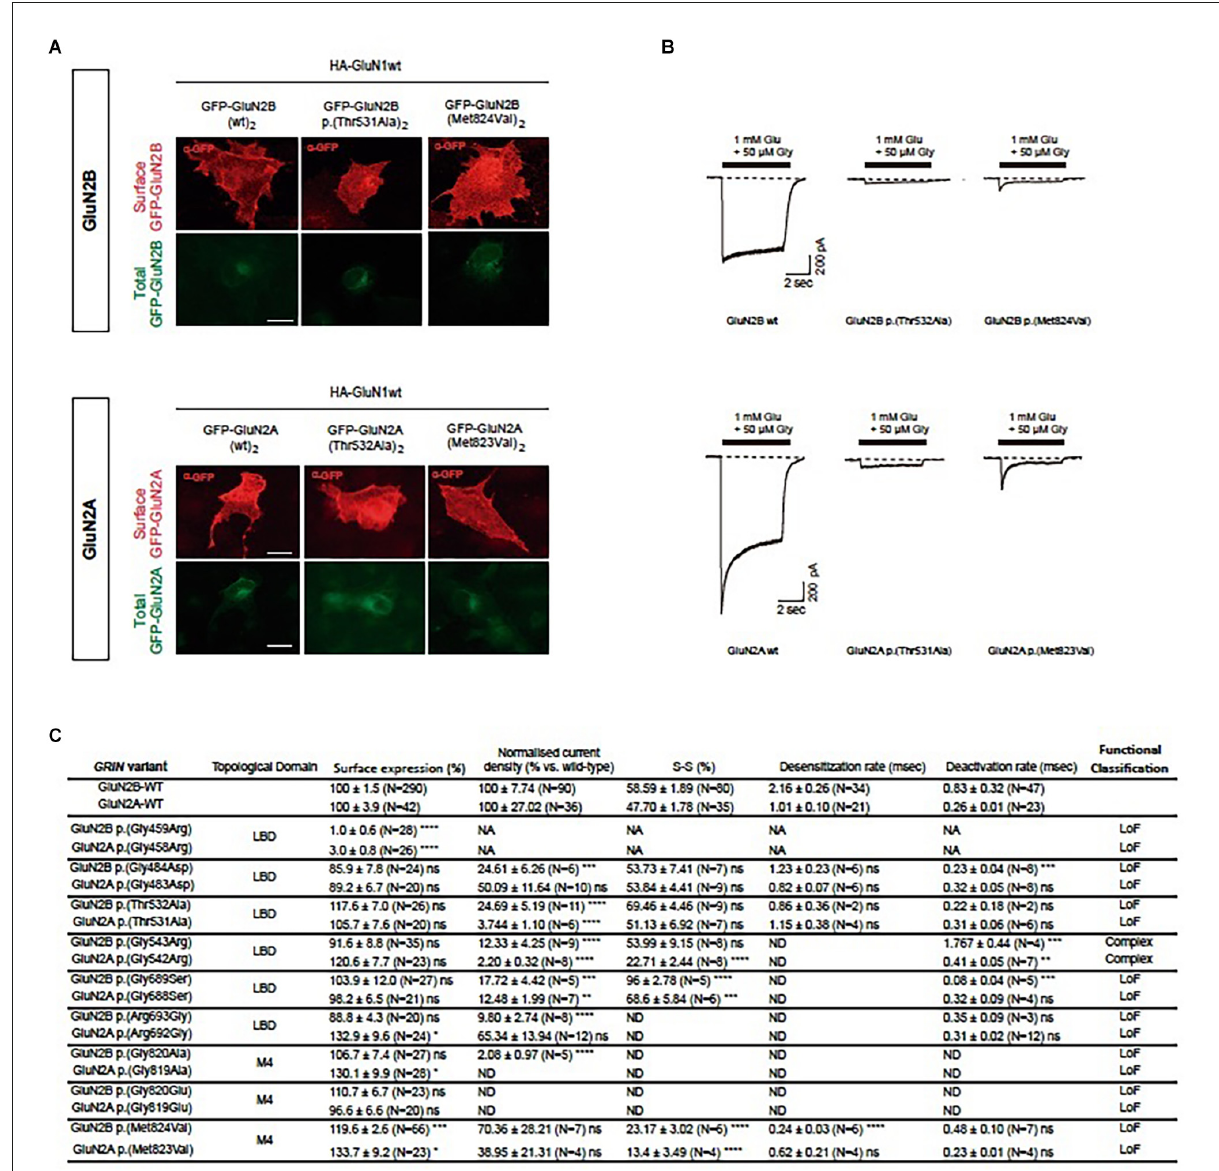
FIGURE2 Comparative analysis of functional alterations in GluN2A-GluN2B predicted equivalent pairs. (A) Representative images of immunofluorescence detection of surface trafficking from artificial GluN2A variants-containing NMDARs (upper panels), designed upon respective patients-associated GluN2B variants (lower panels). Transfected COS-7 cells heterologously expressing GFP-GluN2A/B subunits (green channel, intracellular expression) were immunostained and surface expression of mutant GluN2A/B labeled (red channel). (B) Representative electrophysiological traces of NMDAR-mediated currents in HEK-293T cells transfected with GluN1 and GluN2A/2B pairs (upper panels: (GluN1wt) 2 -(GluN2Amut) 2 mediated currents; lower panels: (GluN1wt) 2 -(GluN2Bmut) 2 ). (C) Summary of functional annotations of GluN2A/2B pairs. Data representing mean ± SEM. art, artificial GRIN2A variant; LBD, ligand binding domain; TMD, transmembrane domain; ns, non-significant statistical difference; * P < 0.05, ** P < 0.01, *** P < 0.001, **** P < 0.0001; ND, not detectable; NA, not